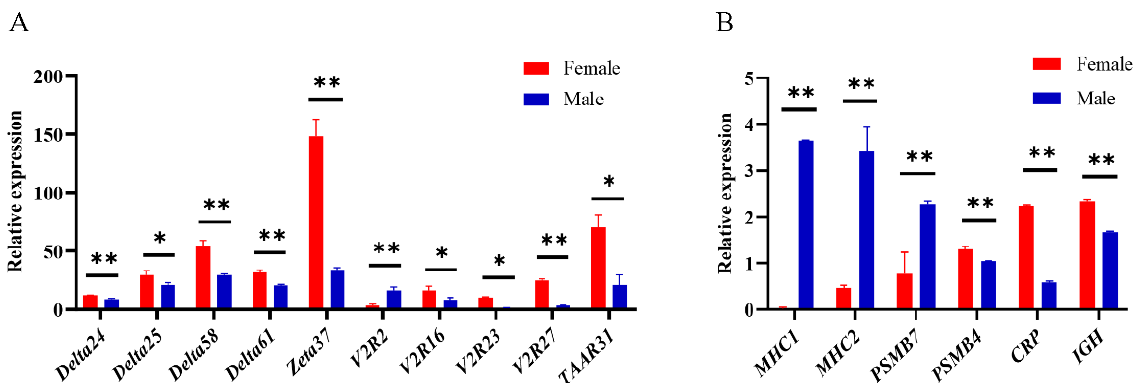
Figure 7. Expression analysis of differentially expressed genes. ( A ) Quantitative RT-PCR analysis of differentially expressed olfactory receptor genes. ( B ) Quantitative RT-PCR analysis of differentially expressed immune genes. Statistically significant differences from the males and females are marked as * P < 0.05 and ** P < 0.01.